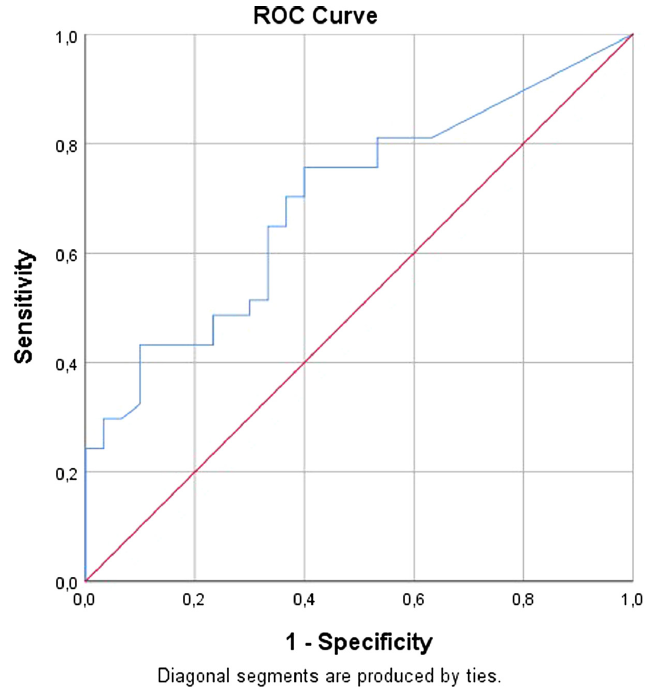
Figure 4. ROC curve based upon AHNAK2 urinary concentrations to determine the diagnostic characteristics. AHNAK2 urinary levels generated an AUC value of 0.695